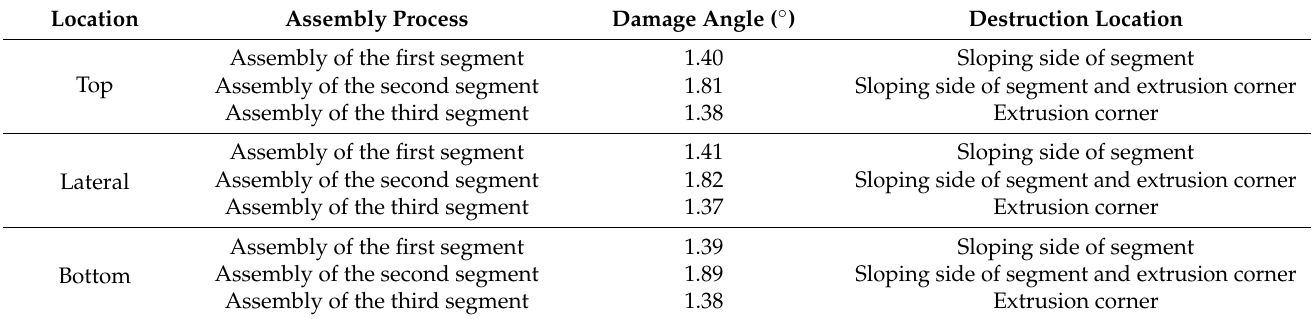
Table 6. Damage to the segments.